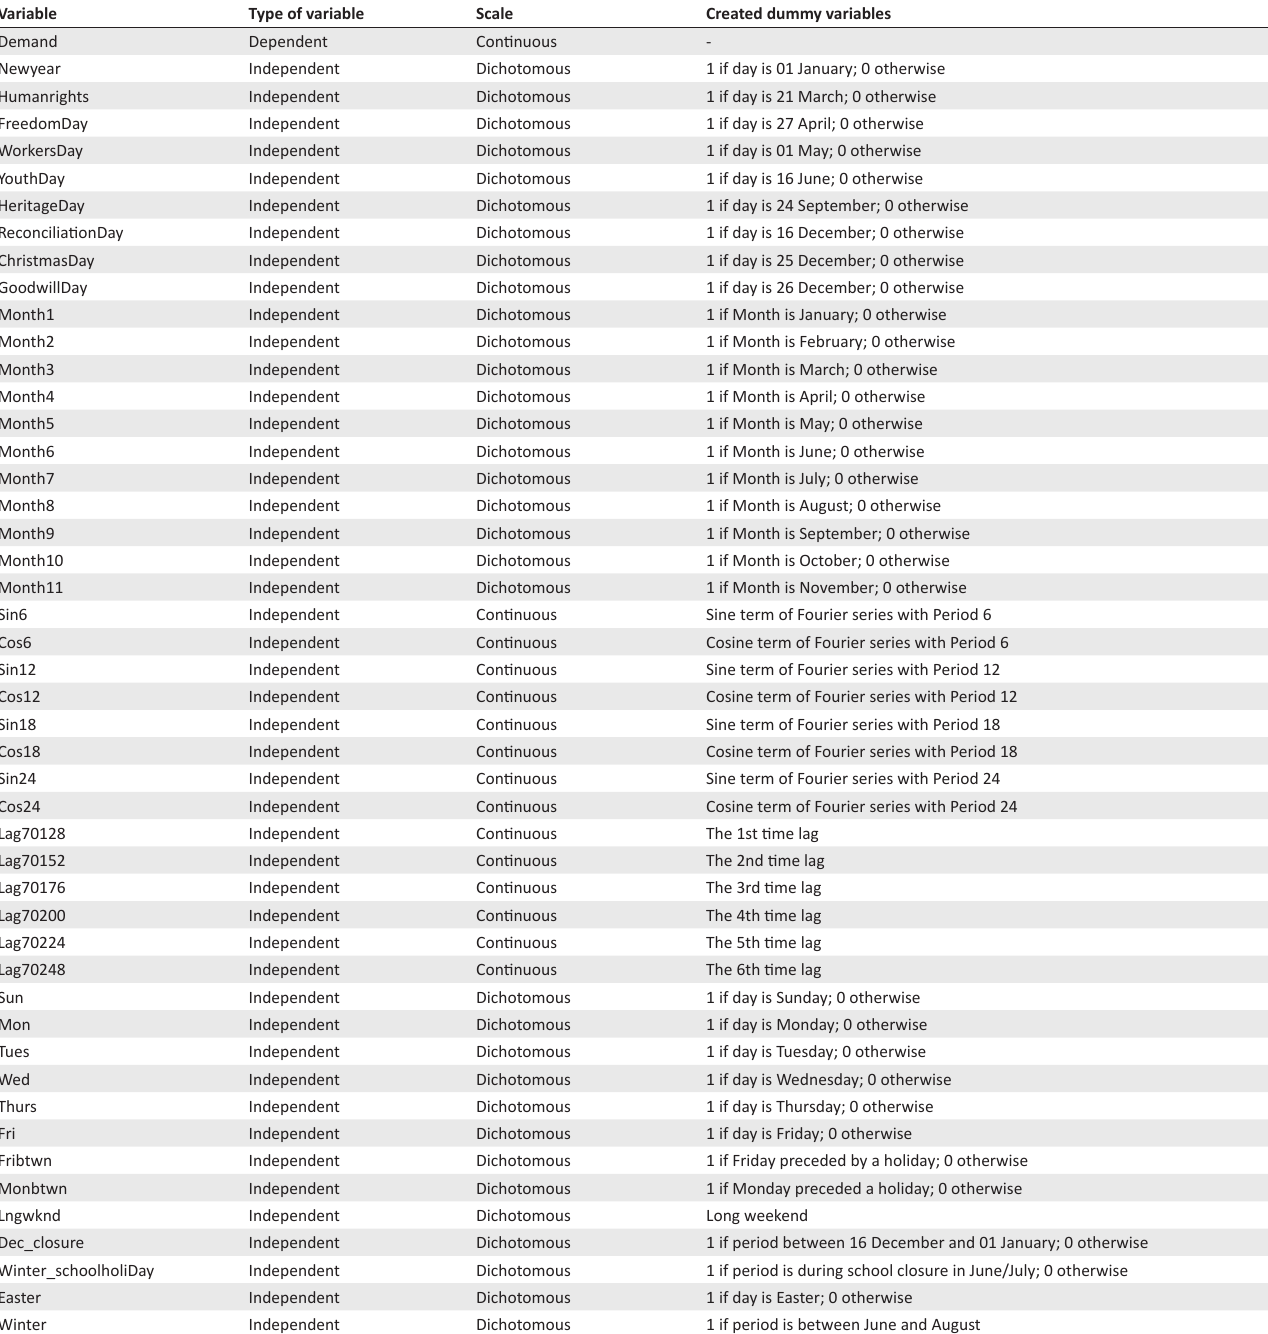
TABLE 1: Variables used in the quantile